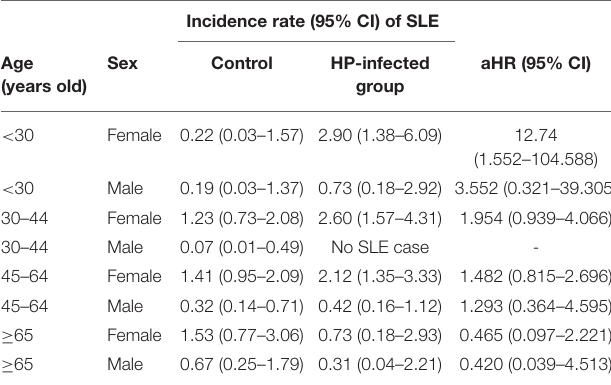
TABLE 5 | Systemic lupus erythematosus (SLE) risk in patients with Helicobacter pylori infection stratified by age–sex subgroups. Incidence rate (95% CI) of